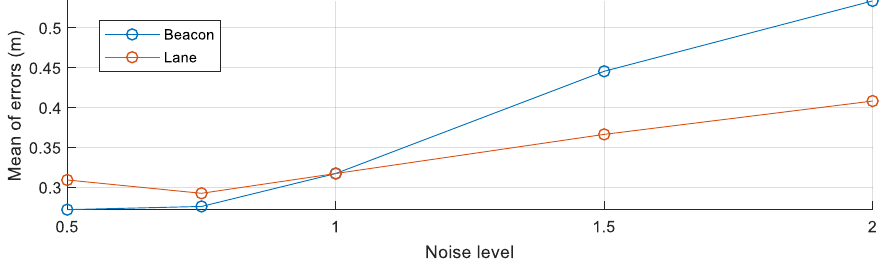
Figure 8. The mean of the errors of the integrated features along to the